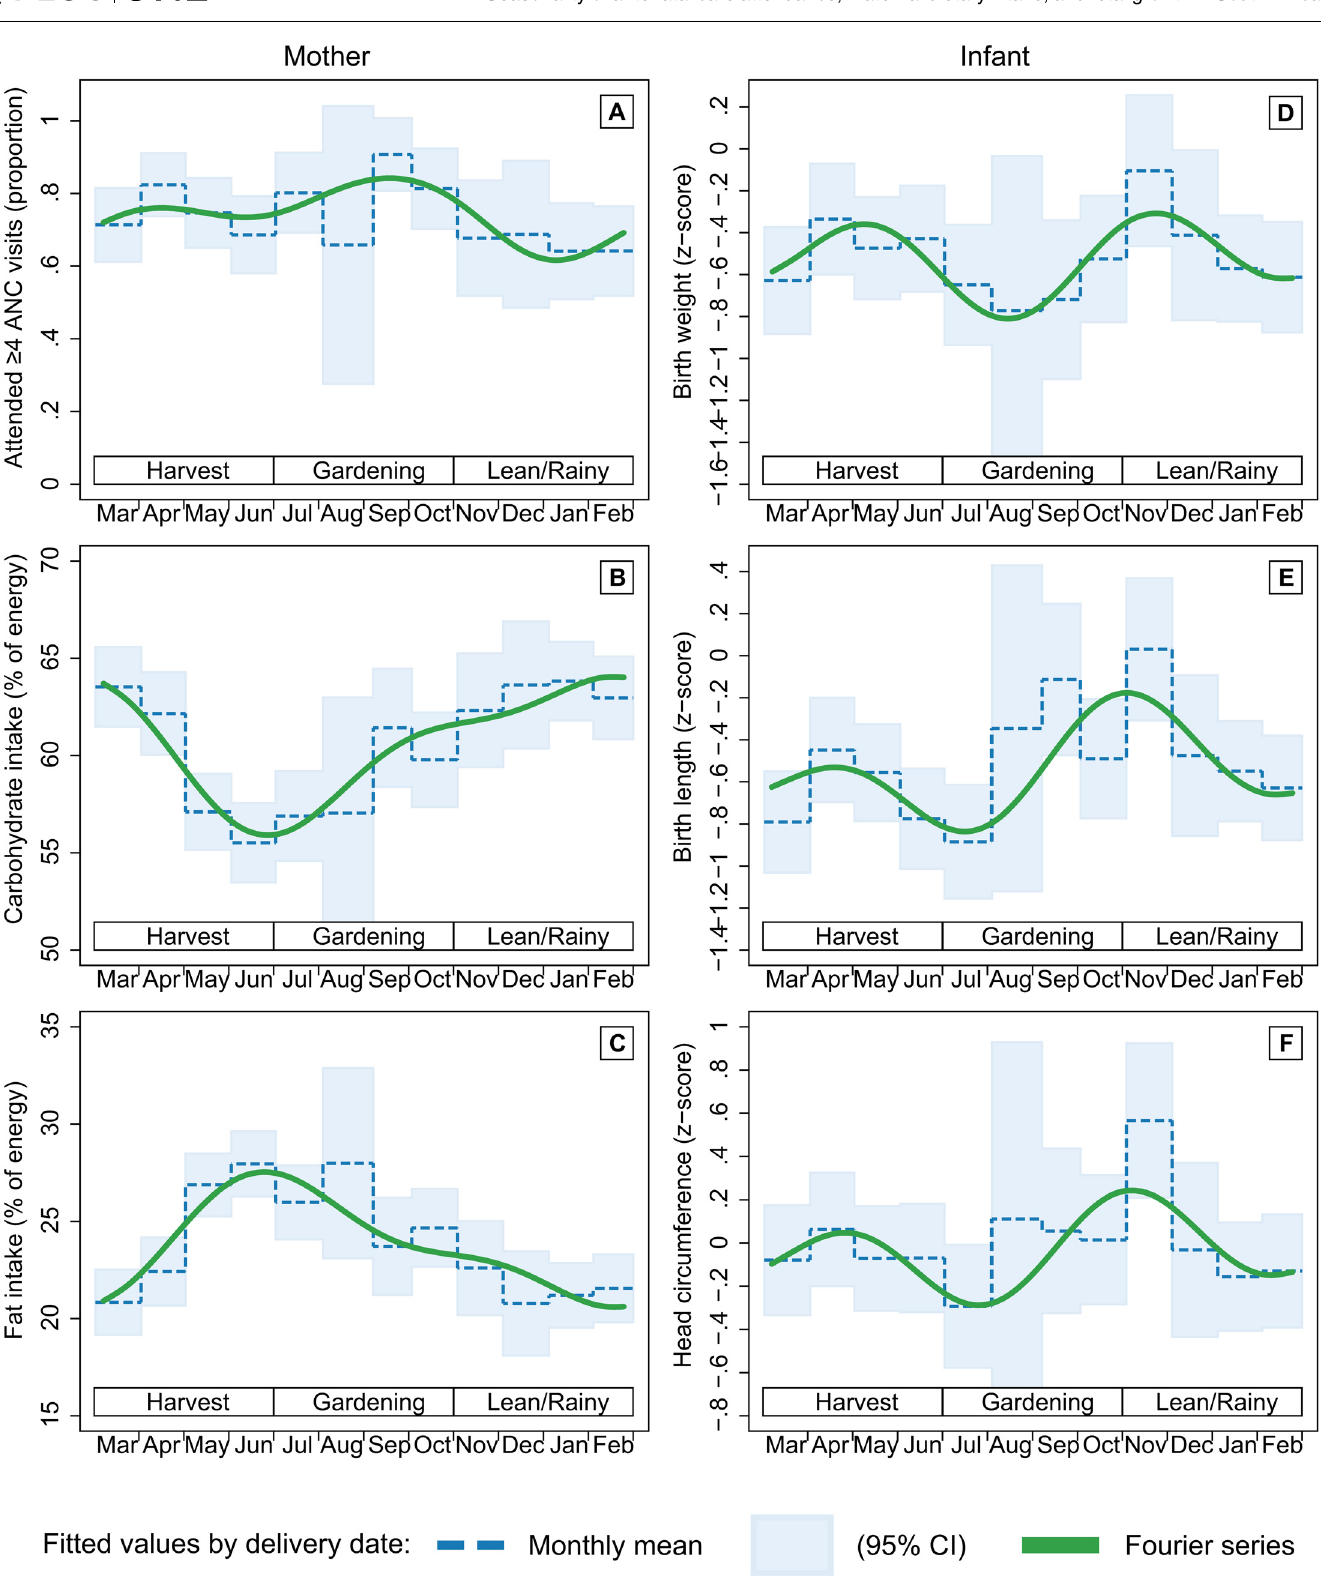
Fig 2. Fitted values of antenatal care (ANC) attendance, maternal dietary intake, and infant birth size by date of delivery, VHEMBE study, South Africa, 2012– 2013. Fourier series models were fitted with first and second order terms for (A) attendance at 4 or more ANC visits during pregnancy; (B) maternal carbohydrate and (C) fat intake as a percent of total energy in the month before delivery; and (D) infant birth weight, (E) length, and (F) head circumference z-scores standardized by gestational age and sex.